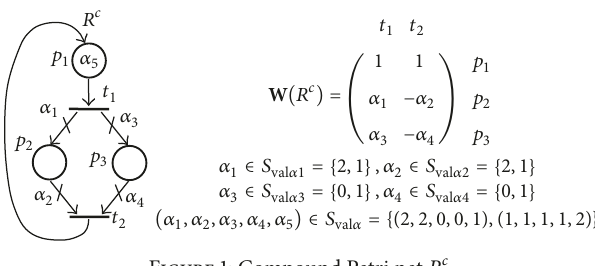
Figure 1: Compound Petri net 𝑅 𝑐 .